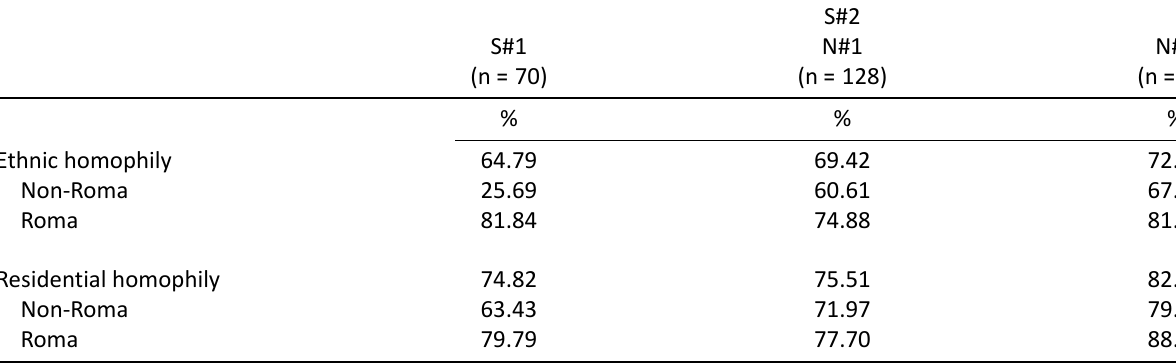
Table 3. Ethnic and spatial homophily of bonding